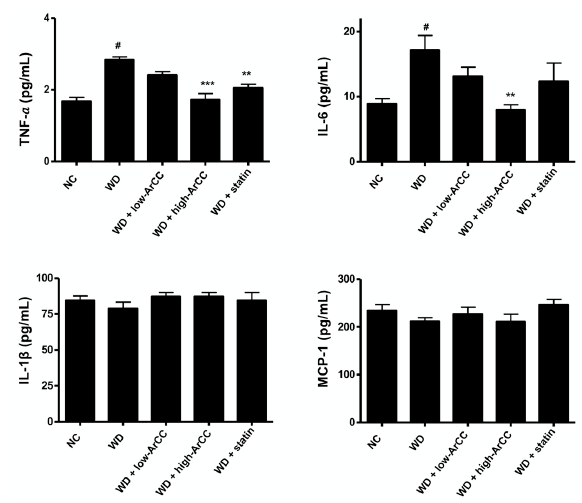
Figure 5. ArCC administration reduces inflammatory cytokine levels in plasma of western diet ApoE − / − mice. The levels of plasma cytokines from ApoE − / − mice at the indicated conditions were measured by multiplex. ApoE − / − mice were fed a normal or western-type diet with or without ArCC for 12 weeks. Data are representative of experiments with at least eight mice in each group. # p <0.05 versus NC ; ** p < 0.01, *** p < 0.001 versus WD as determined by one-way analysis of variance followed by Bonferroni’s multiple comparison tests.